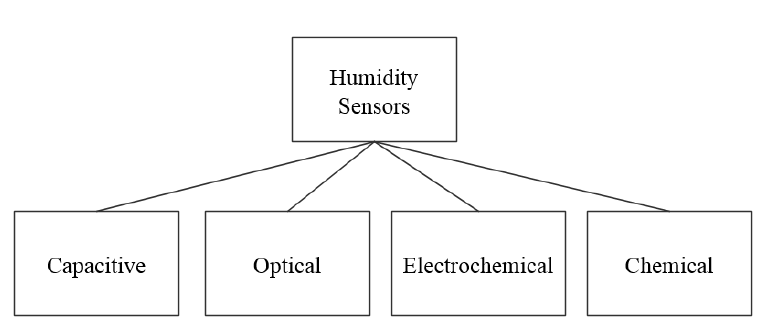
Figure 8. Working principles of surveyed humidity